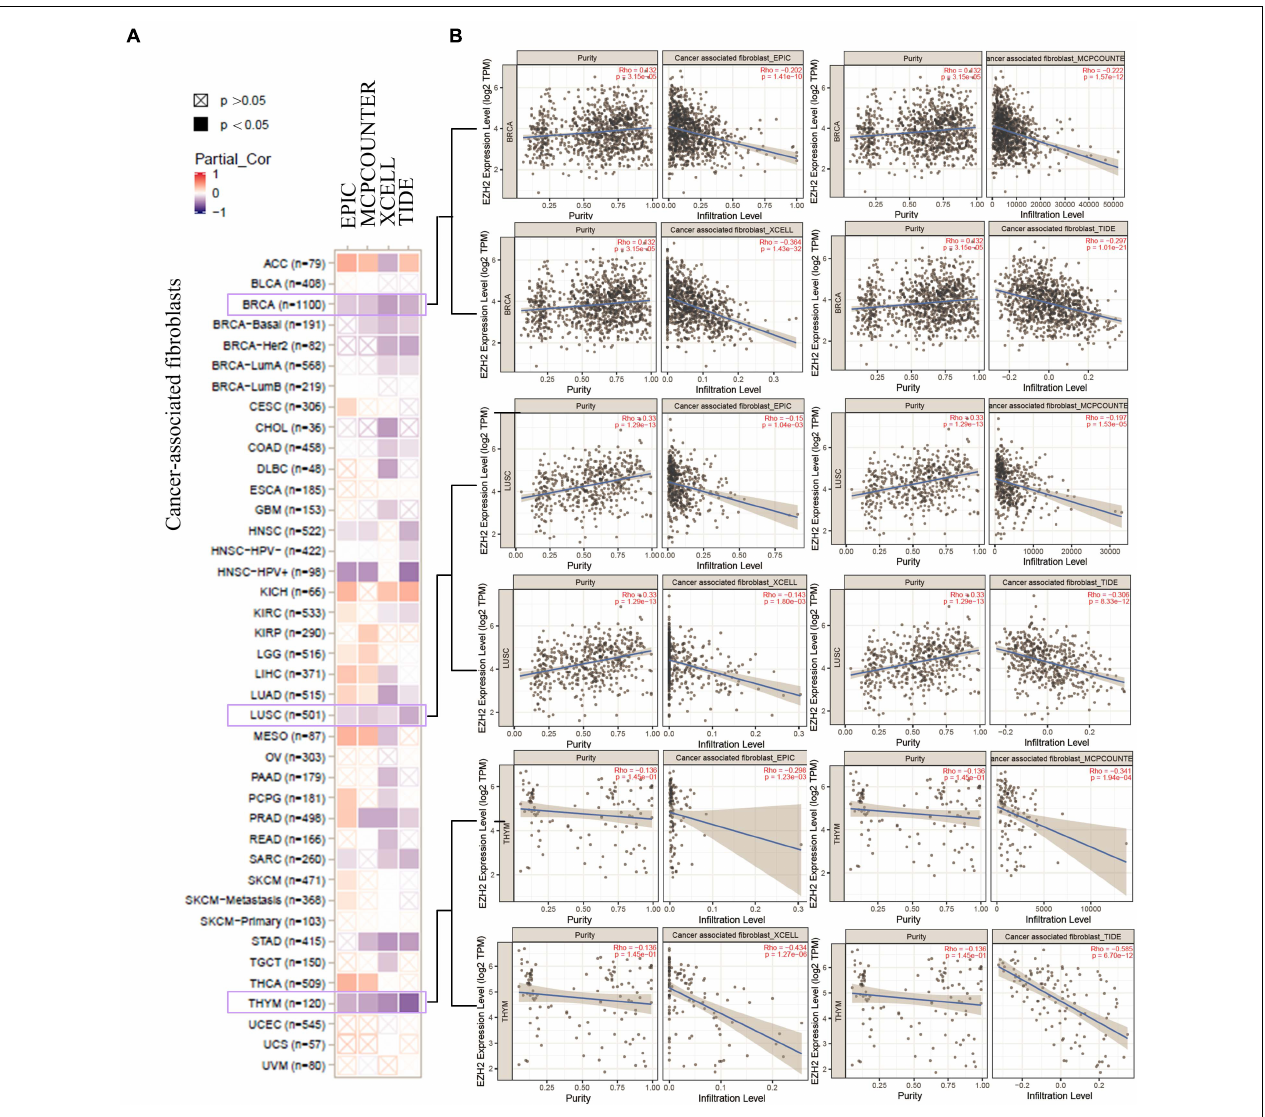
FIGURE 8 | Correlation analysis between EZH2 expression and cancer-associated fibroblasts. (A) Four algorithms (EPIC, MCPCOUNTER, XCELL, and TIDE) were used to explore the correlation between EZH2 expression and the infiltration level of cancer-associated fibroblasts as the form of a survival map. (B) Scatter plots were present for BRCA, LUSC, and THYM